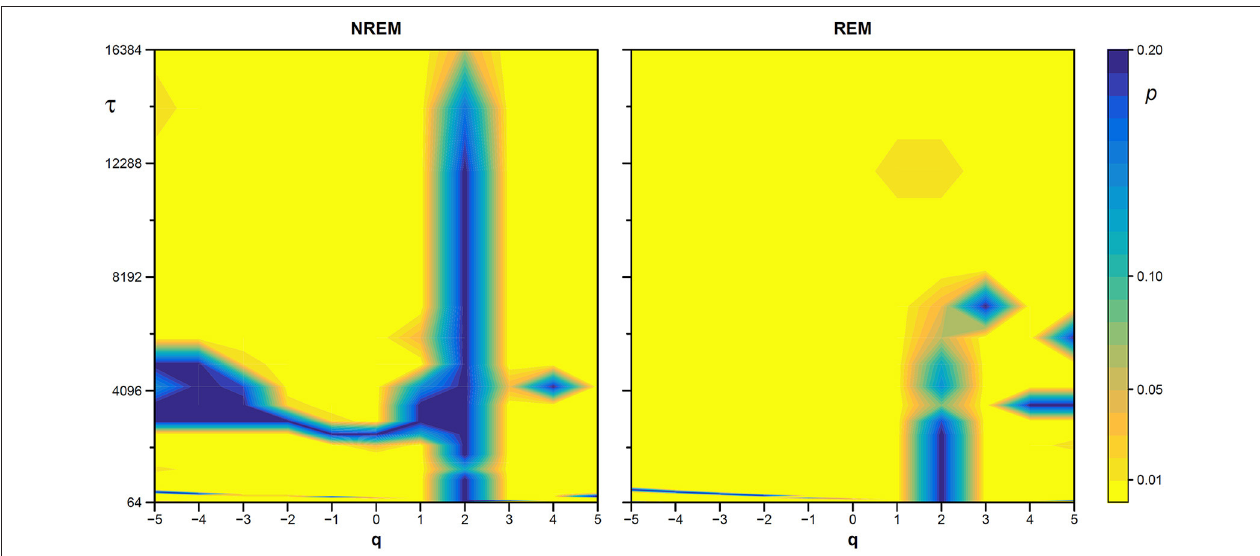
FIGURE 13 | Statistical significance of nonlinearity test on EEG scale coefficients. Each point represents the two-sided, type-I error probability to reject the null hypothesis comparing scale coefficients of the original series and of Fourier-phase shuffled surrogate series at each scale τ and moment-order q ; differences significant at p < 0.01 are indicated in yellow. The scale, τ , in milliseconds, is the box size n multiplied by the sampling period.